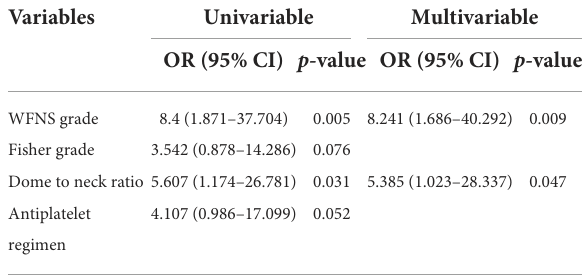
TABLE 3 Univariable and multivariable analyses of thromboembolic